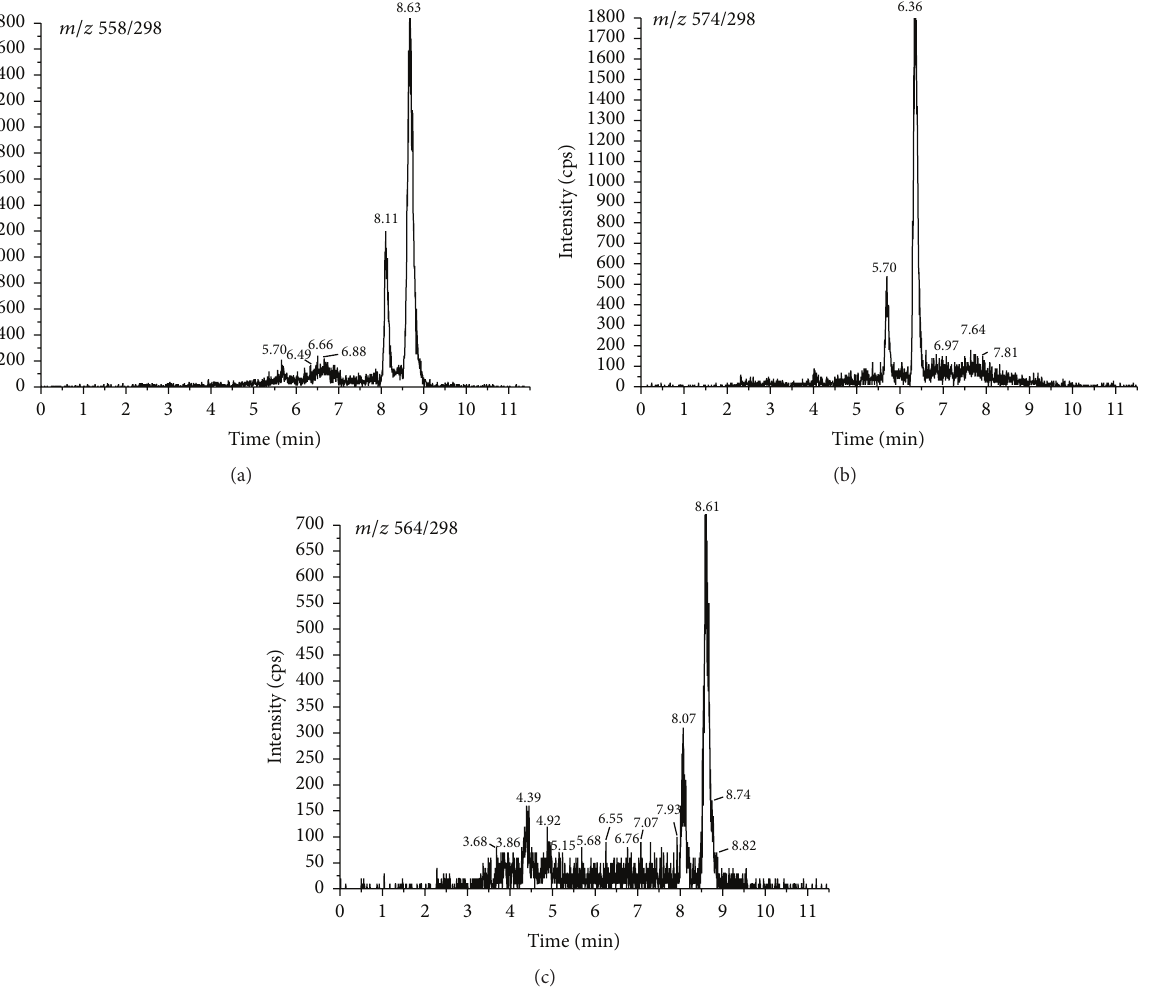
Figure 2: The representative MRM chromatograms for 25(OH)D 3 -PTAD (a), 24,25(OH) 2 D 3 -PTAD (b), and d6-25(OH)D 3 -PTAD (c) of